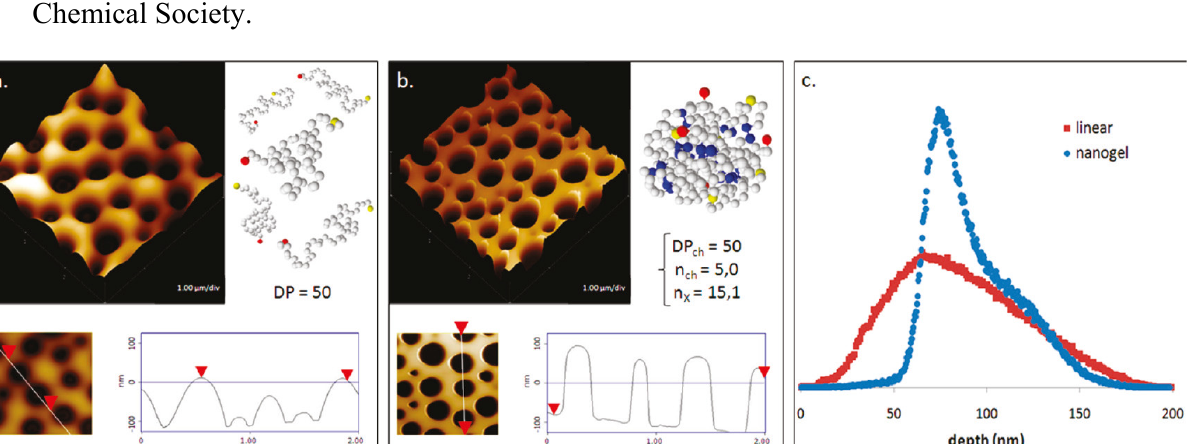
Figure 12. Atomic force microscopy (AFM) topography images and profiles for films prepared on graphite by spin coating nanogel solutions in THF/H O (98/2 vol %/vol %) at 2 a concentration of 10.0 mg/mL. (Inset) Thoeretical structure. DP ch: degree of polymerization of the constitutive chains. Nch: average number of constitutive chains. Nx: average number of cross-link. ( a ) Linear polymer (DP = 50). ( b ) Nanogel (DP ch = 50; synthesis parameter: Co = 2050 mol/kg [Xa]0 = 5.00 × 10 − 2 mol/kg and x = 12.10%). ( c ) Depth histograms corresponding to surfaces obtained with linear polymers (squares) and nanogels (circles) as shown in a and b, respectively. Reproduced with permission from Reproduced with permission from Poly et al. Langmuir 2011 , 27 , 4290 [181]. Copyright 2011 American Chemical Society.